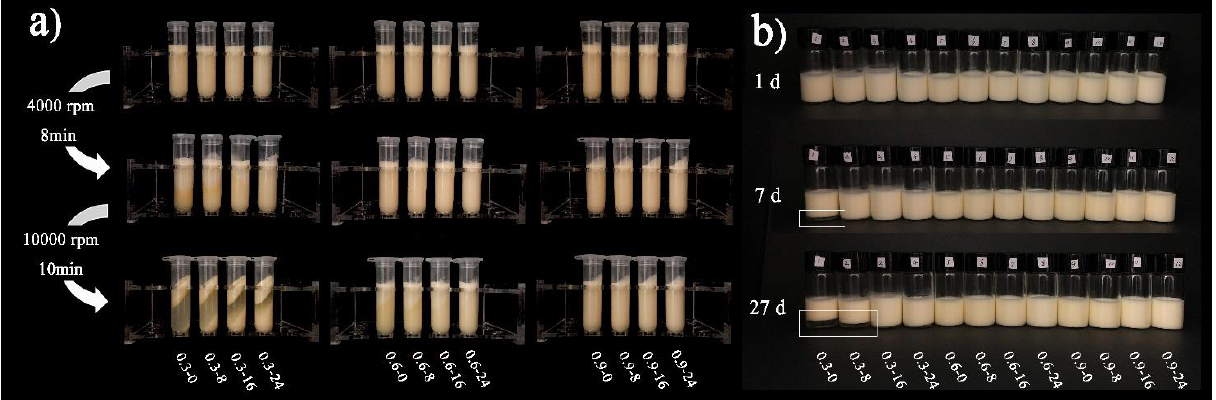
Figure 7. Kinetic stability of model mayonnaises: ( a ) centrifugation stability; ( b ) storage stability.